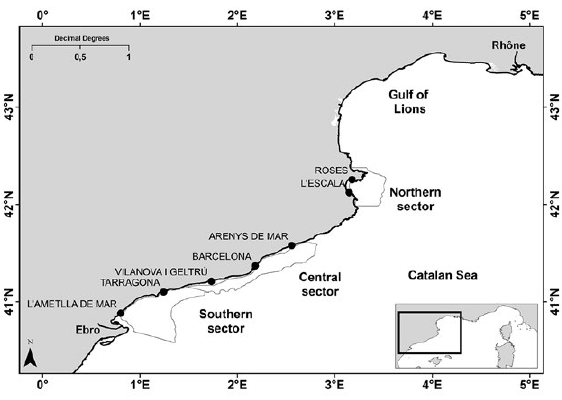
Fig. 1. – The study area divided into three sectors (Southern, Central and Northern) limited by the 35 m and 200 m isobaths and their major fishing ports.